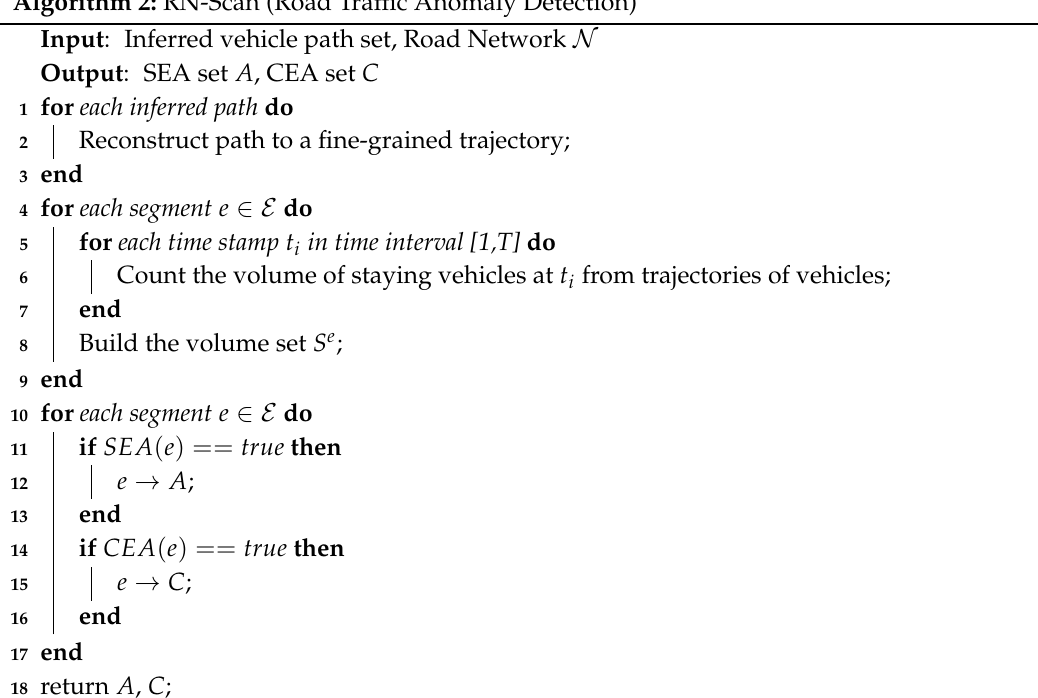
Algorithm 2: RN-Scan (Road Traffic Anomaly